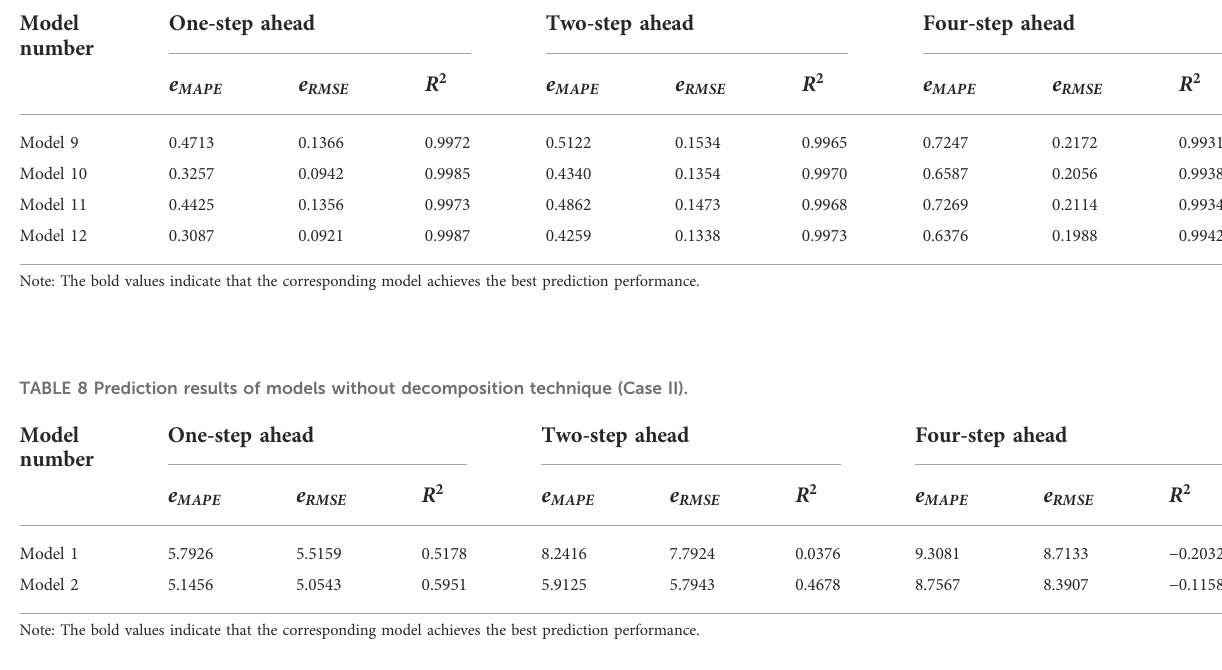
TABLE 7 Prediction results of the model combined with quadratic decomposition technique (Case I).